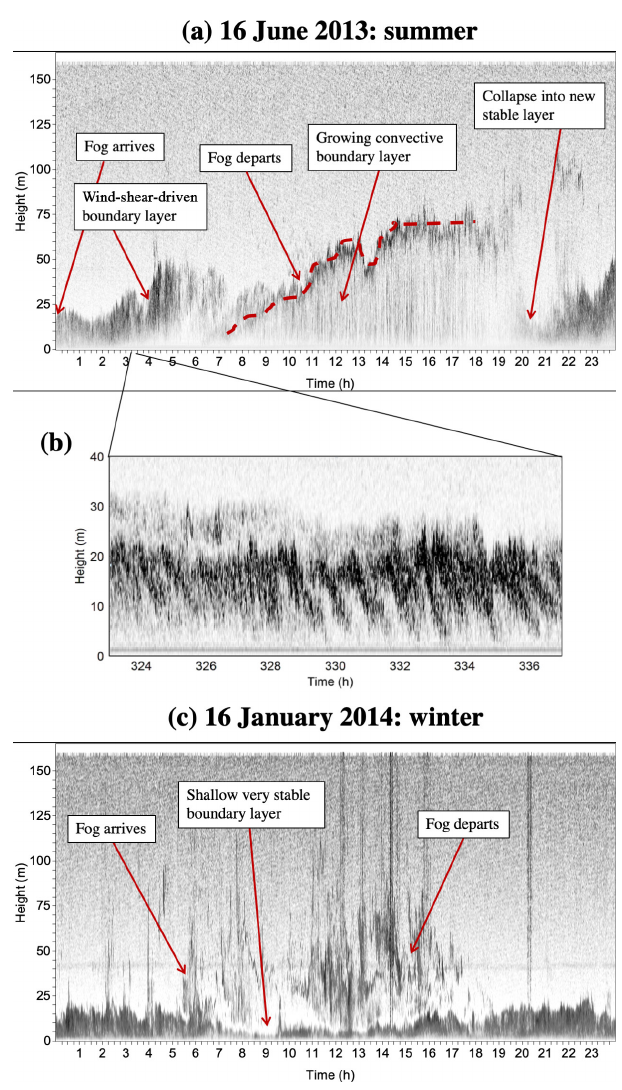
Figure 7. Sodar facsimile records between the surface and 160m height for the summer case (16 June 2013, a ). Panel (b) shows an expansion of a brief period from 03:23 to 03:37UTC and 0–40m height from panel (a) to highlight the Kelvin–Helmholtz instabili- ties observed at this time. Panel (c) is similar to (a) but for the winter case on 16 January 2014. Dark features that extend to the top of the plot in panel (c) (e.g., near 20:00UTC) are likely noise from station activities and the horizontal feature in panel (c) near 40m height is due to reflections of a side lobe from an object nearby on the ice